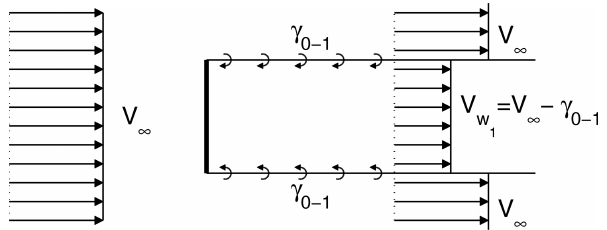
Figure 5. Schematic view of a uniformly loaded disc in a uniform inflow.